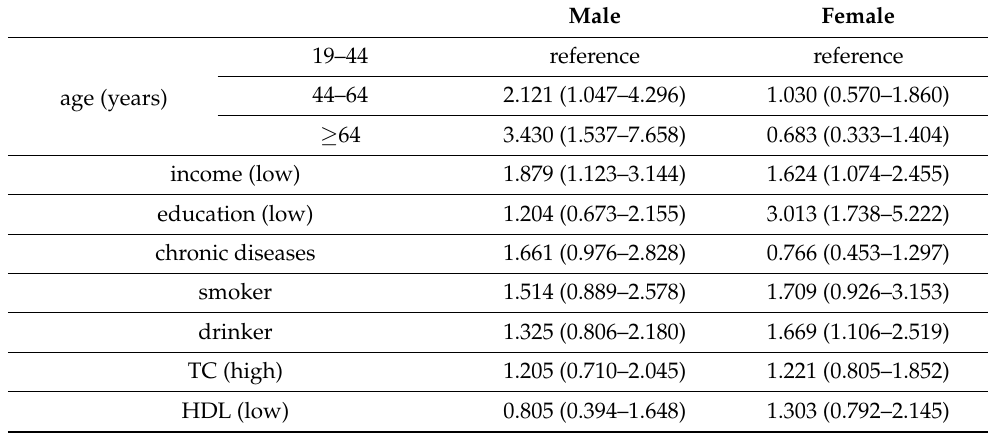
Table 4. Association between serum cholesterol and suicidal ideation according to